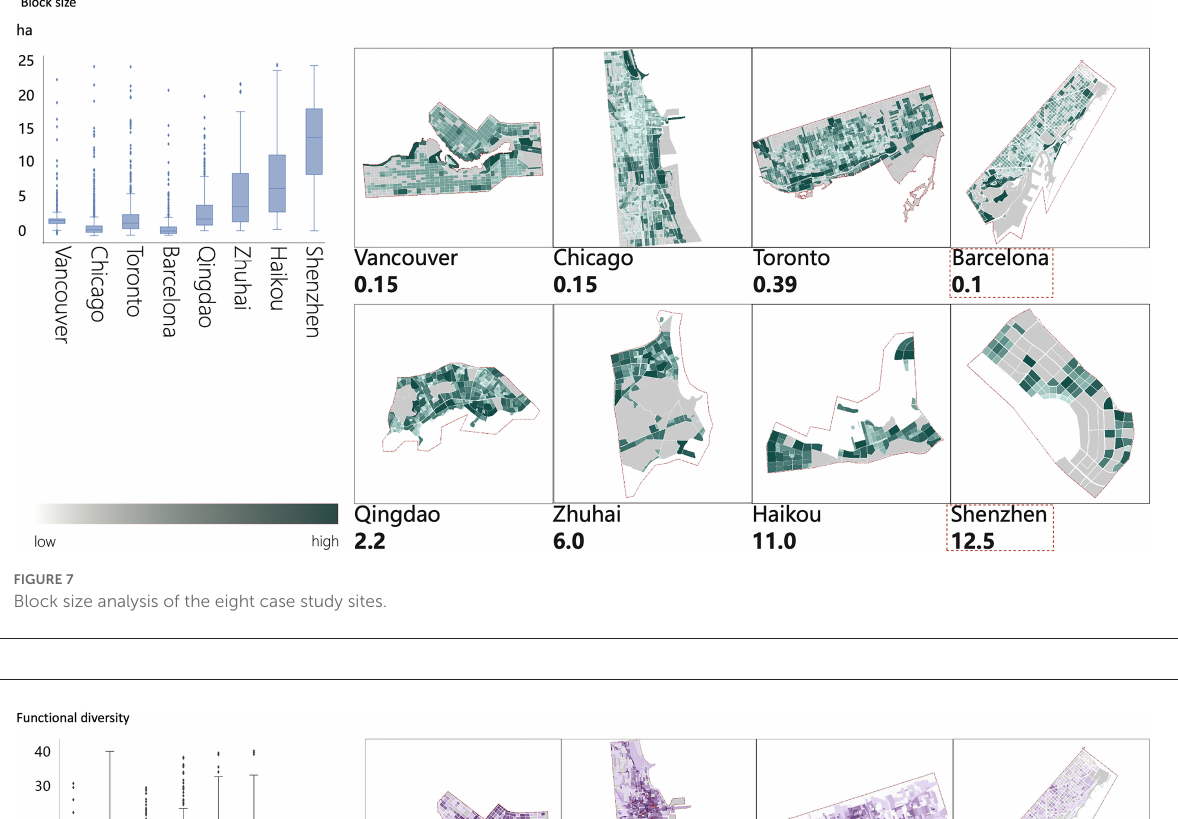
FIGURE7 Block size analysis of the eight case study sites.